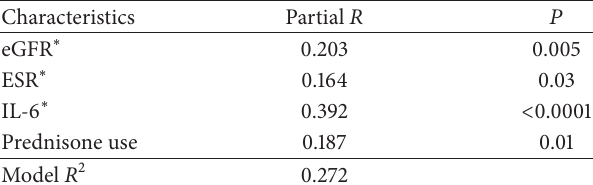
Table 3: Independent associations between cardiovascular risk factors and the endothelial score when entered into the same model.